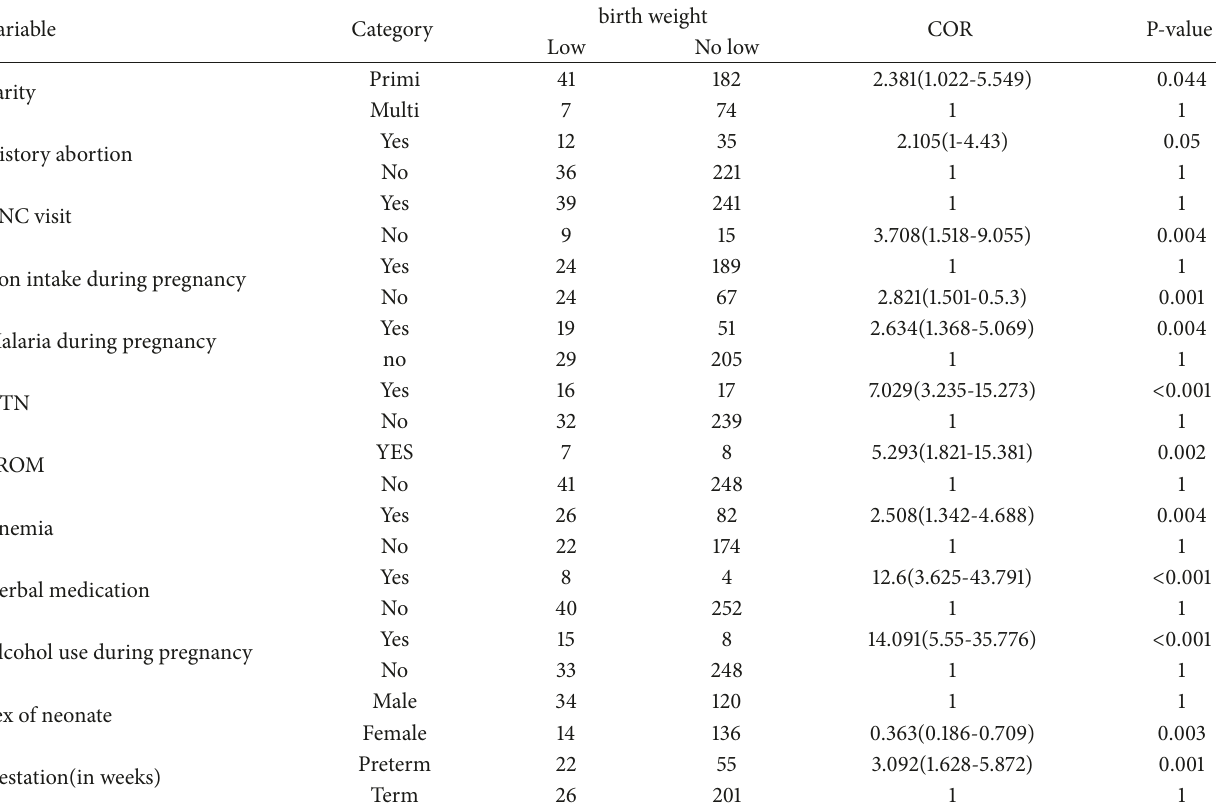
Table 2: The association between low birth weight and independent variables among newborns delivered at Wolaita Sodo University teaching and referral hospital, Sothern Ethiopia,